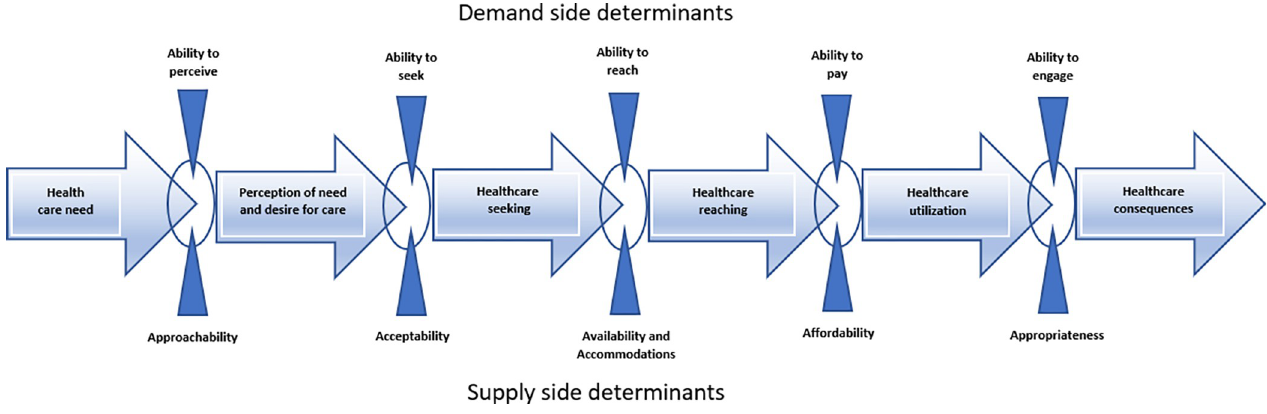
Fig 1. Framework for access to healthcare adapted